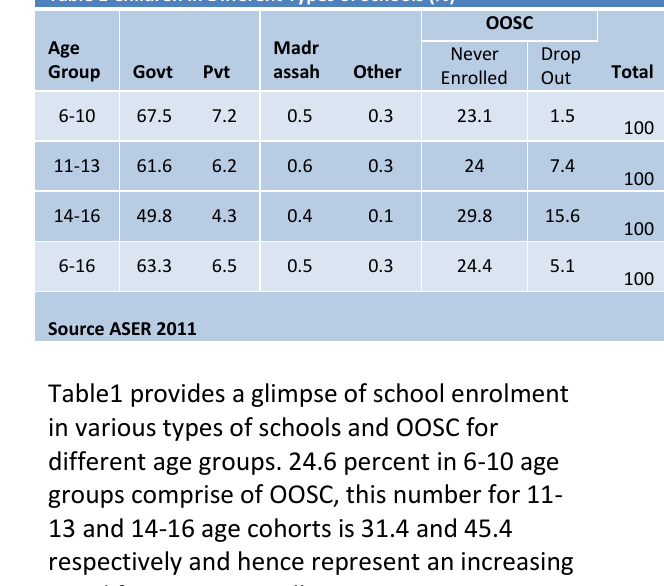
Table 1 Children in Different Types of Schools